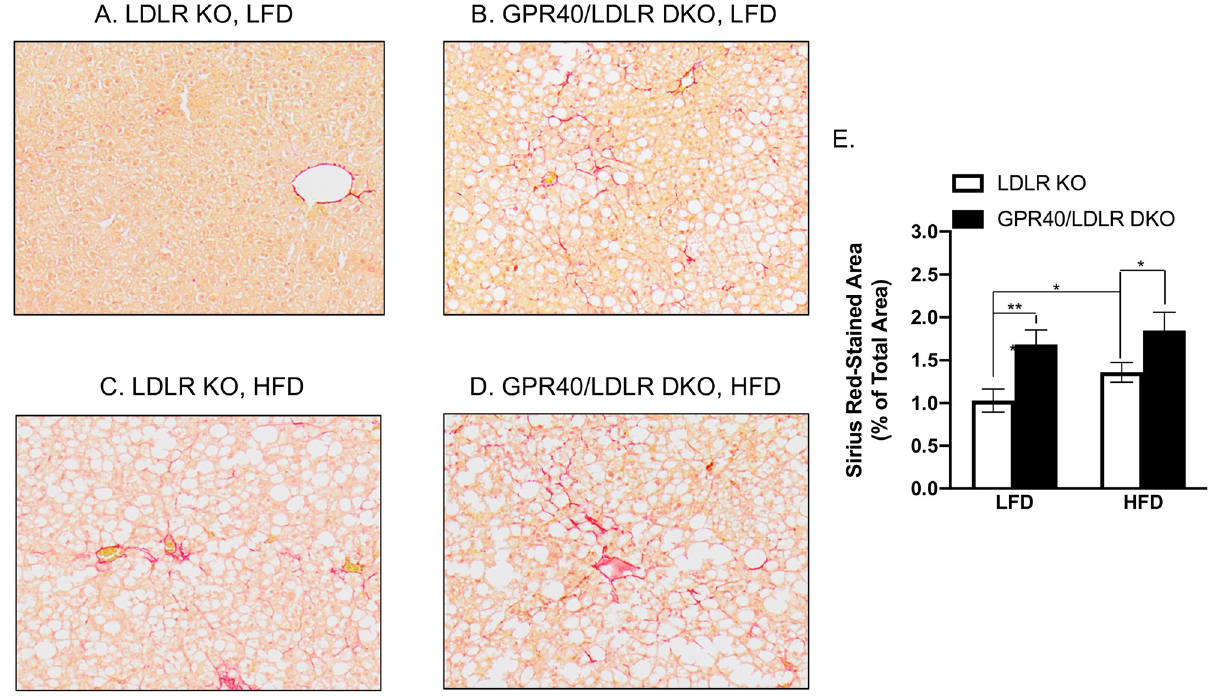
Fig 5. The effect of GPR40 KO on hepatic fibrosis in LFD- or HFD-fed LDLR-deficient mice. A–D: Representative images of liver sections with Sirius Red staining (magnification: x100). E: The positively stained areas of Sirius Red staining were quantified and compared among all groups. The data are presented as means ± SE (n = 6–8). One-way ANOVA and Student’s t test were used for the statistical analysis. � p < 0.05; �� p < 0.01. LFD, low-fat diet; HFD, high-fat diet; KO, knockout; DKO, double